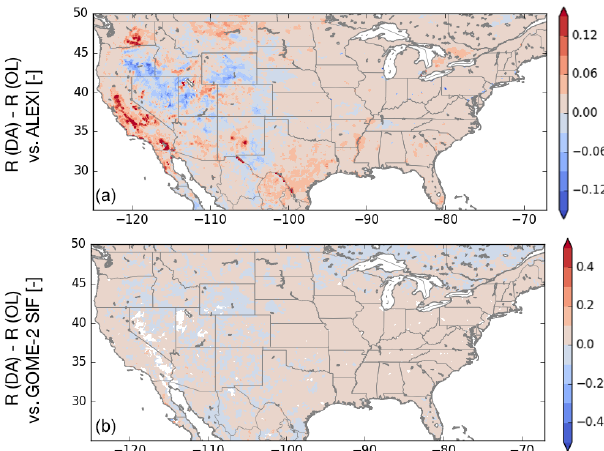
Figure 9. Differences in R values for ET (a) and GPP (b) from the assimilation of SMAP soil moisture and VOD relative to the OL integration, using ALEXI ET and GOME-2 SIF datasets. The warm and cool colors indicate improvements and degradations from